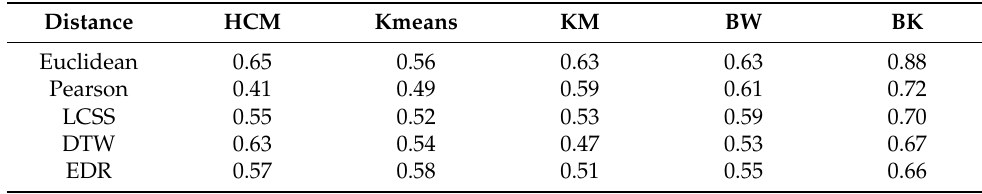
Table 2. SC values of different clustering methods.